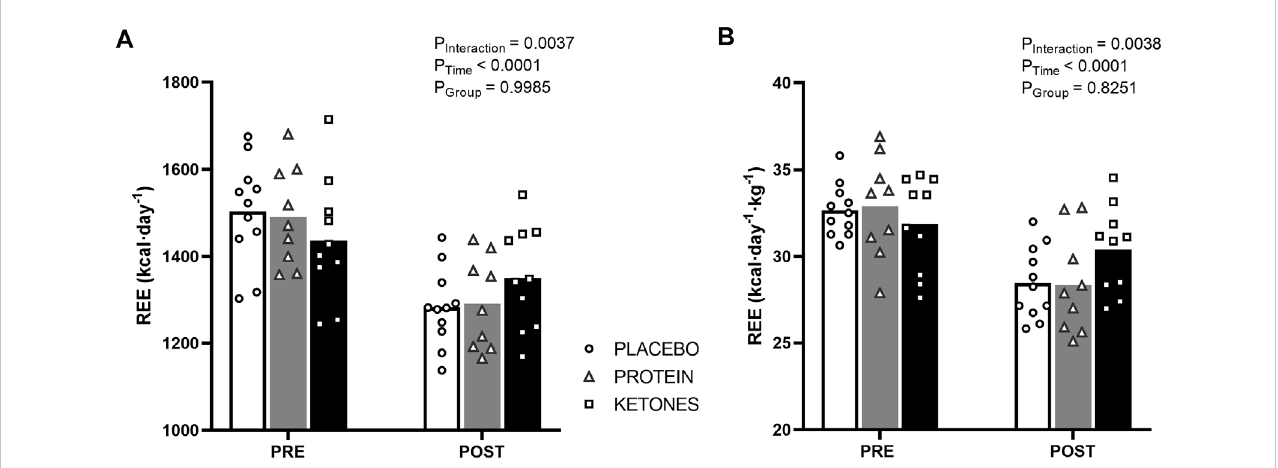
FIGURE 3 Effect of increased protein intake and exogenous ketosis on resting energy expenditure during a hypocaloric diet. Subjects were involved in a 4-week hypocaloric diet (30% energy restriction, .8 – 1.0 g protein · kg BW − 1 · day − 1 ) and received either placebo (PLA: n = 11), an increased amount of dietary protein (PROT: n =9)oraketoneester(KE: n =10).Dataarerepresentedasmeans(whitebars:PLA;greybars:PROT;blackbars:KE)andindividualvalues(circles:PLA; triangles:PROT;squares:KE).Absoluteresting energyexpenditure (A) wasmeasuredbyindirectcalorimetryinthefastedstatebefore(pretest)andatthe end (posttest) of the caloric restriction period. The hypocaloric diet reduced absolute REE in all groups, but to a lesser extend in KE. When REE values were adjusted for lean mass (B) , REE was only reduced in PLA and PROT, and was preserved in KE.